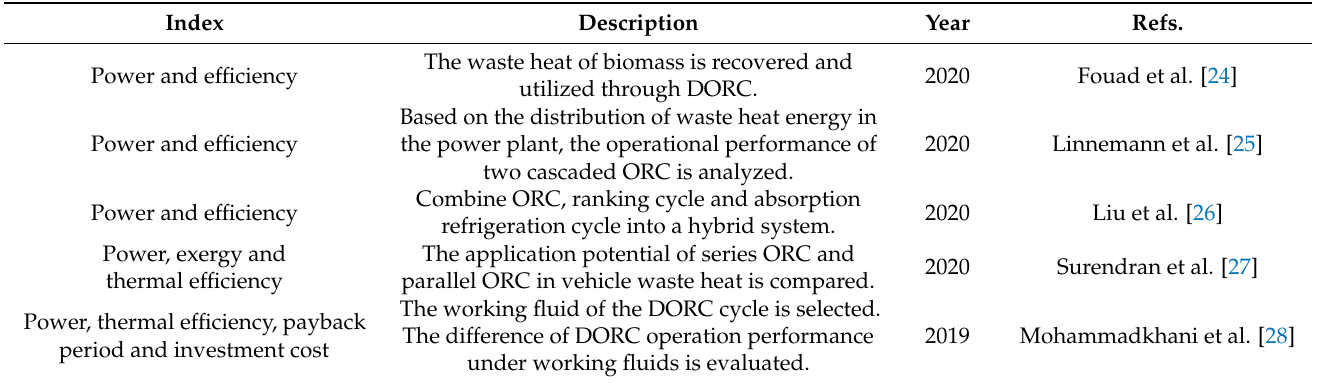
Table 2. Selection of index of